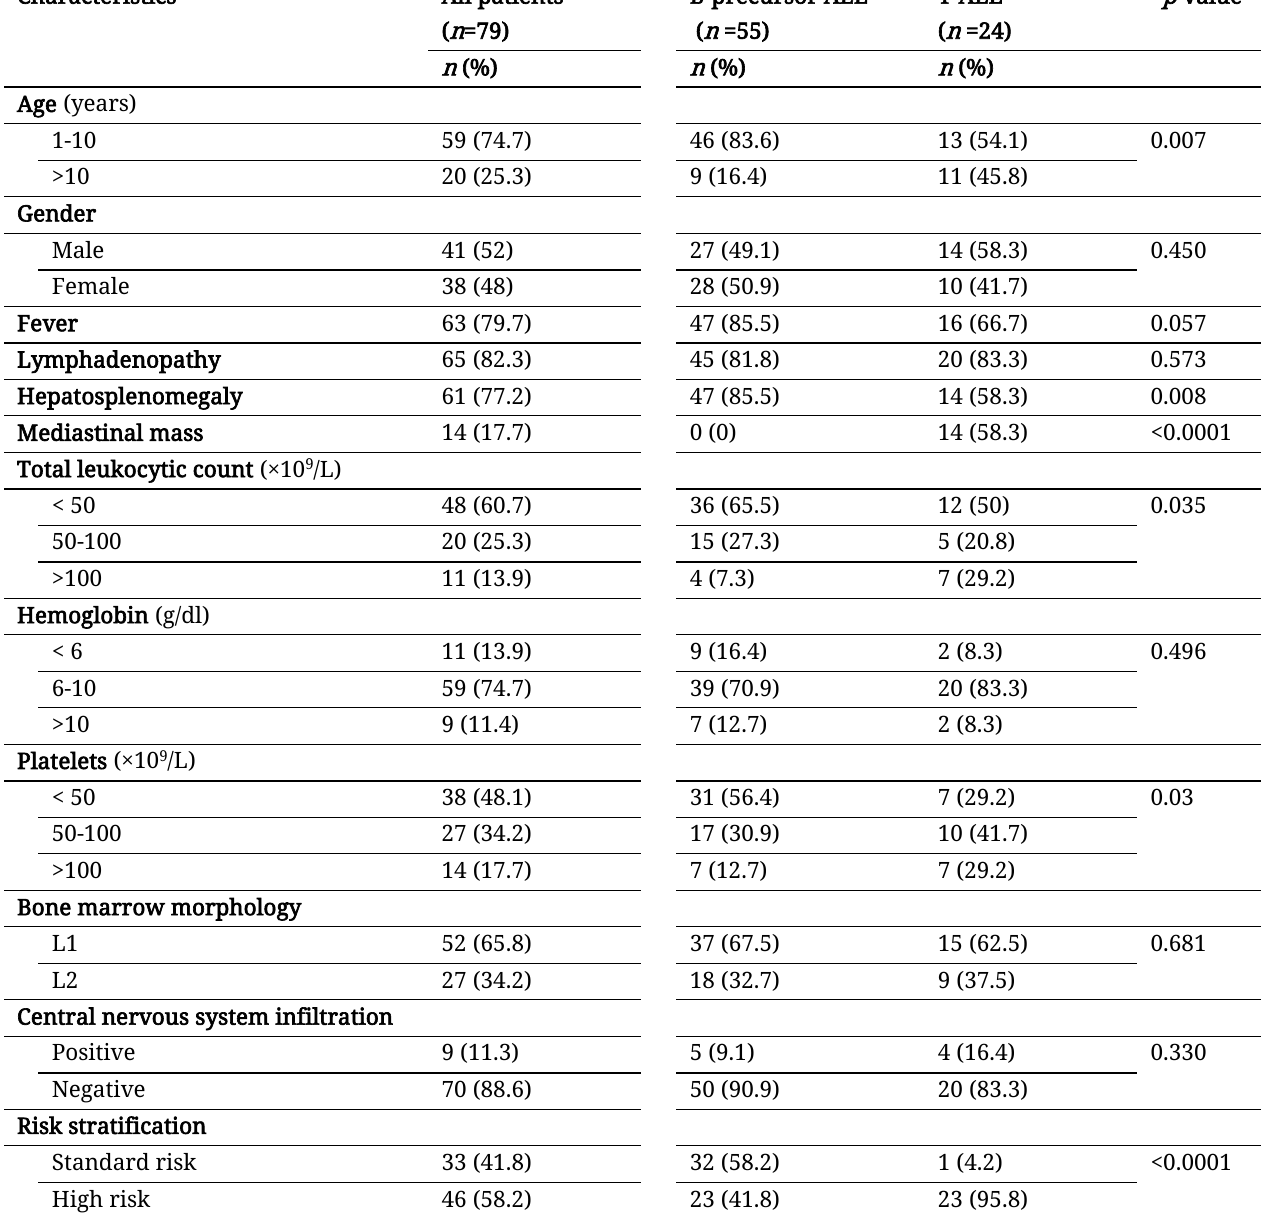
Table 1: Patients and disease characteristics and their distribution according to immunophenotyping